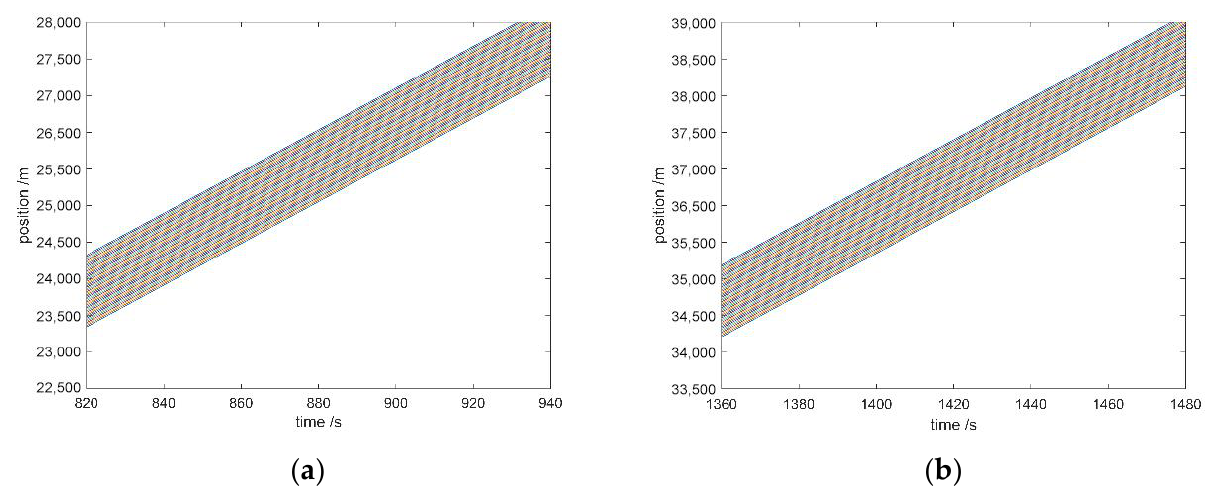
Figure 10. The operation of traffic flow in the unconnected environment: ( a ) Before exerting the disturbance; ( b ) After exerting the disturbance.